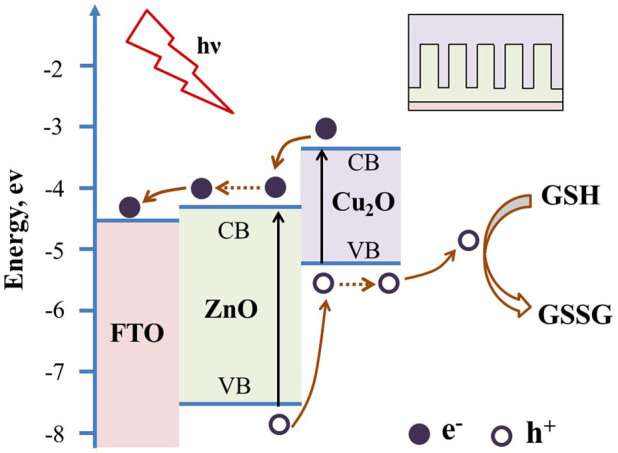
Illustration of the PEC mechanism for GSH biosensing at Cu2O/ZnO NRs array heterostructure based photoanode.